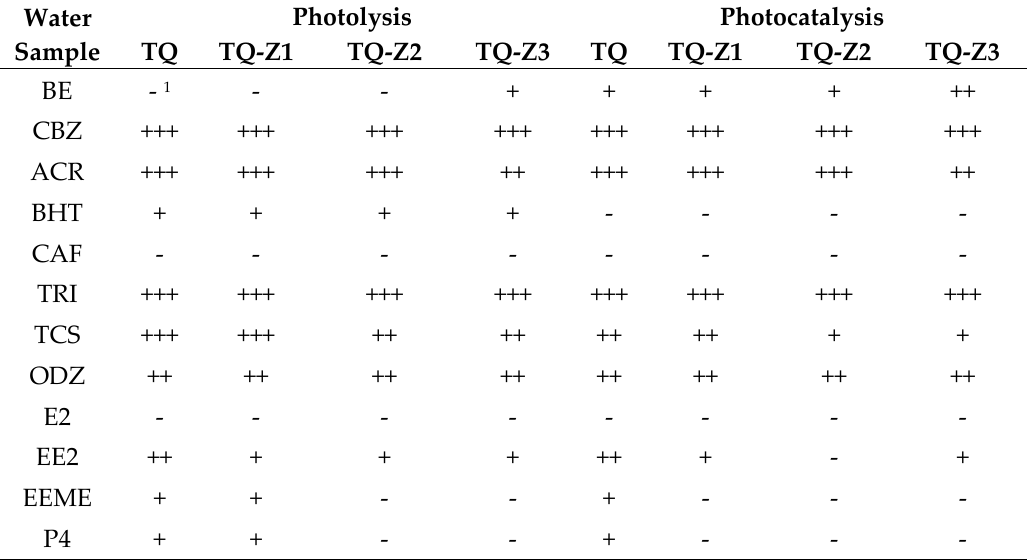
Table 1. Toxicological assessment results after 60 min of photolysis and